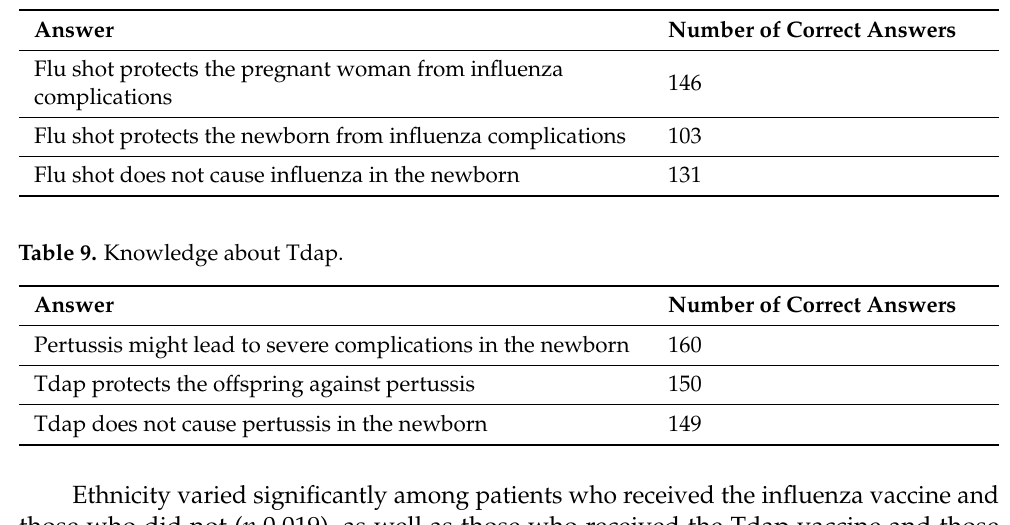
Table 8. Knowledge about the vaccine against influenza.